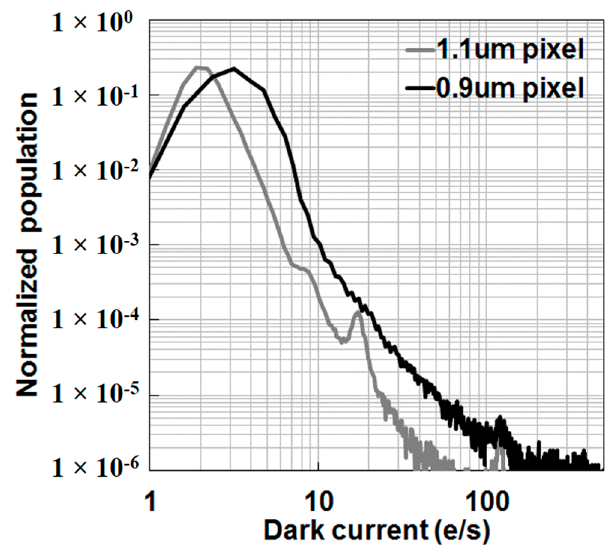
Figure 11. Dark current histograms at 60 °C of the 0.9 µm pixel and the 1.1 µm pixel. The gray color indicates the 1.1 µm pixel, and the black color indicates the 0.9 µm pixel.